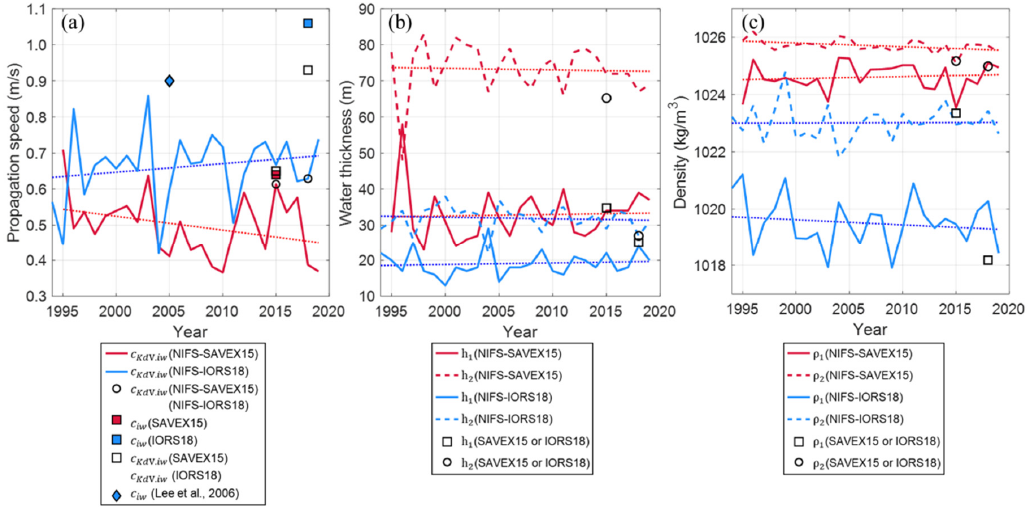
Figure 10. ( a ) Time series of propagation speed estimated from the method proposed in this study (colored squares; red for SAVEX15 and blue for IORS18) and KdV theory (open squares, open circles, and colored lines). KdV theory was applied using the NIFS historical hydrographic data for May (red line and open circle) and August (blue line and open circle), and hydrographic data obtained during SAVEX15 and IORS18 (open squares). The propagation speed of NLIWs observed in the northern ECS in August 2005 [33] is denoted by a blue diamond. Time series of ( b ) thickness ( h 1 and h 2 ) and ( c ) density ( ρ 1 and ρ 2 ) of the upper (solid lines) and lower (dashed lines) layers derived from the NIFS historical hydrographic data for May (red) and August (blue), and hydrographic data obtained during SAVEX15 and IORS18 (open squares and circles for upper and lower layers, respectively). Long ‐ term trends of ( a ) propagation speed, ( b ) layer thickness, and ( c ) layer density from 1994 to 2019 are remarked with dotted lines.